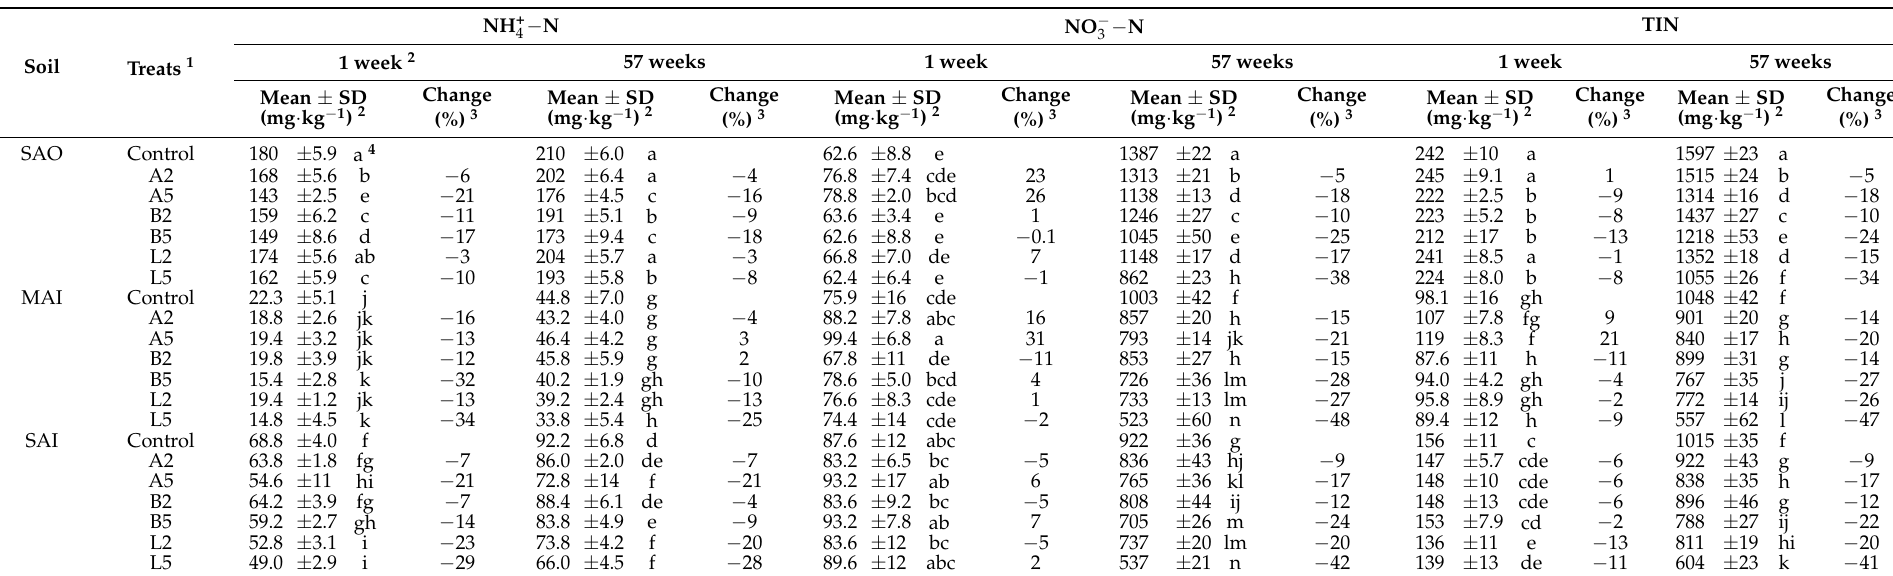
− N, NO − − N, and total inorganic N (TIN) (NO − 3 4